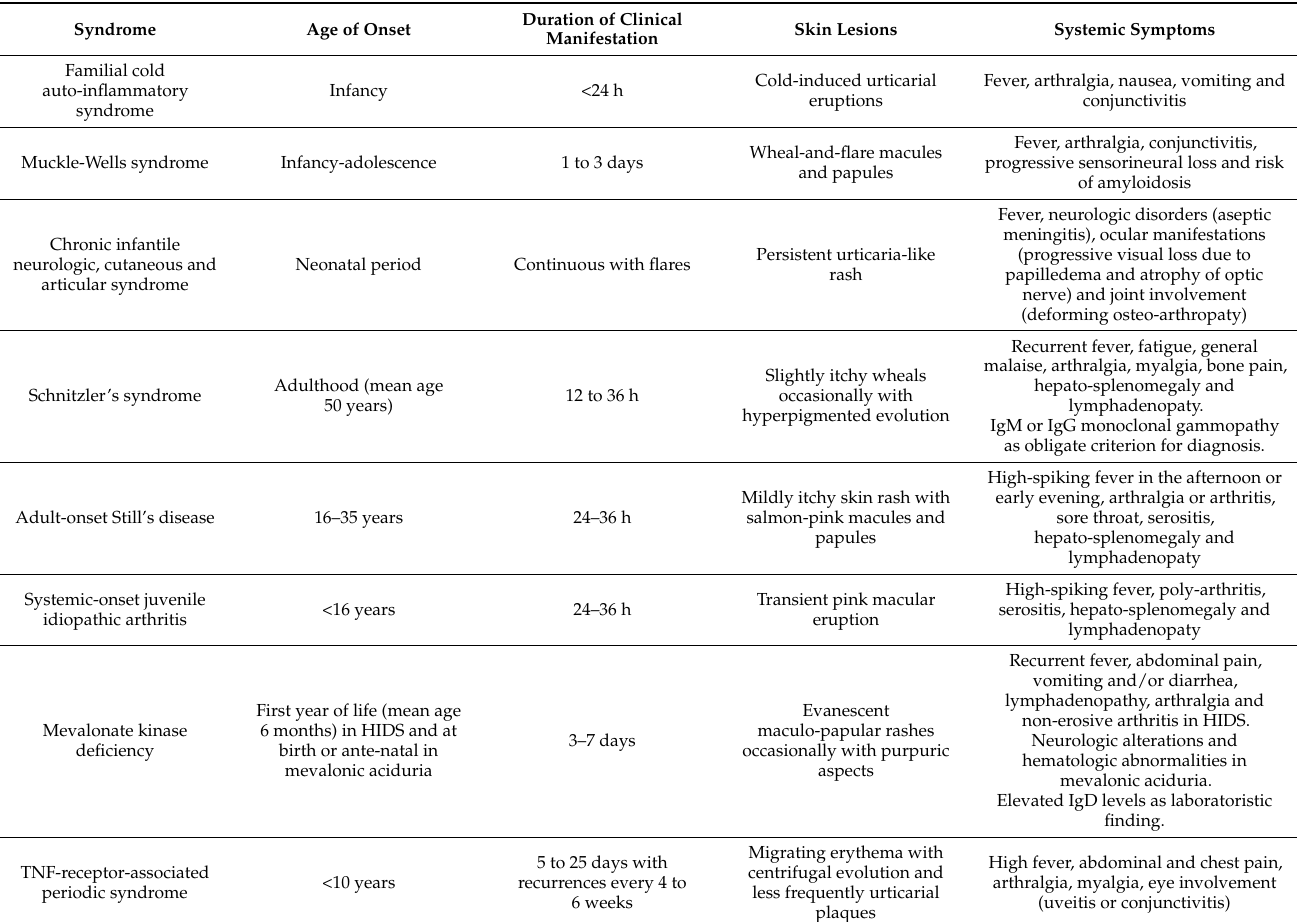
Table 2. Principle autoinflammatory urticarial